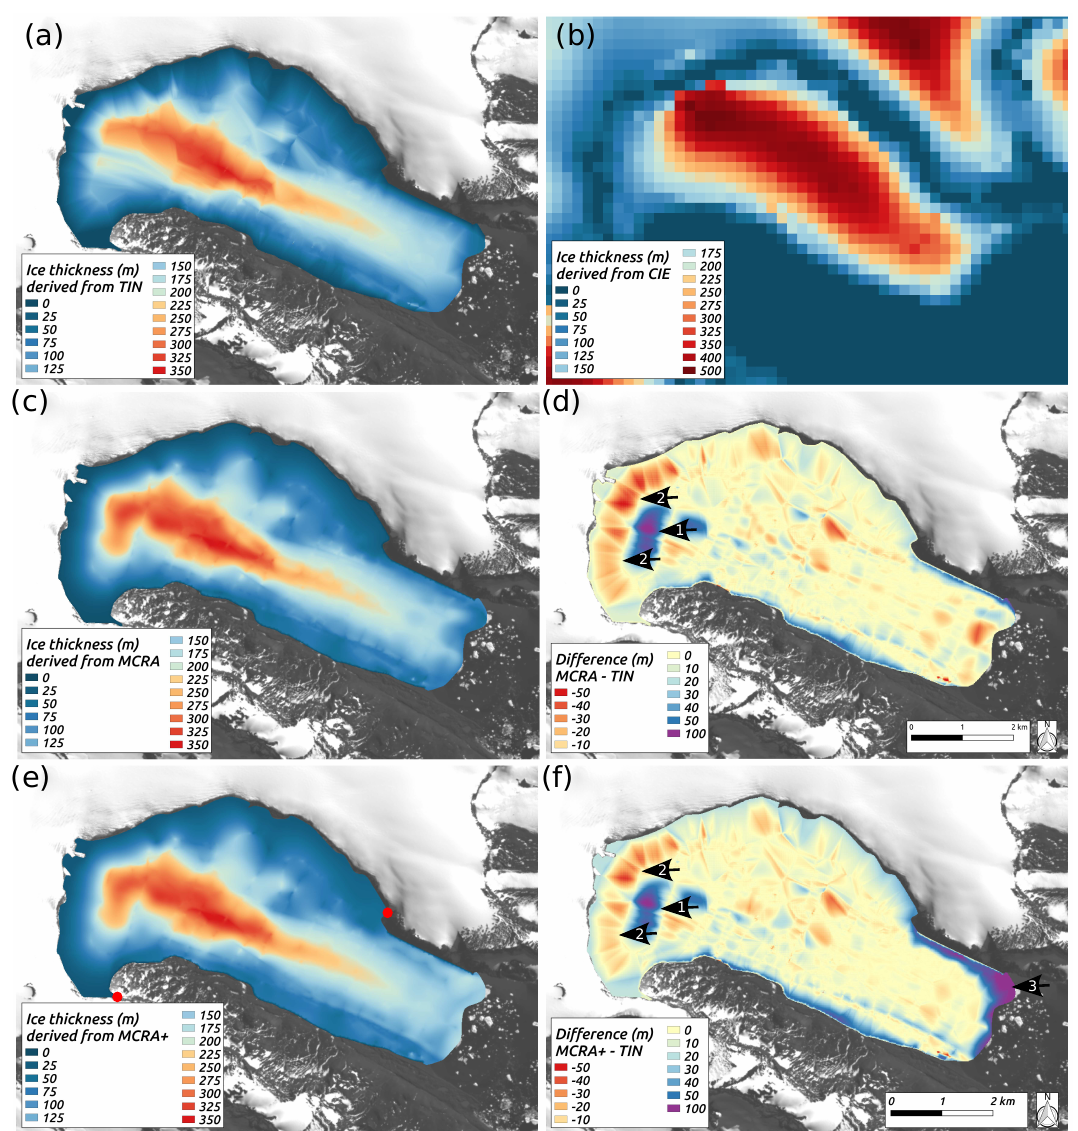
Figure 9. ( a ) Ice thickness measurements from 2018 with ( a ) TIN interpolation, ( c ) reconstruction using the MCRA, and ( e ) reconstruction using the MCRA+ with adding mass input from the plateau. ( b ) Simulated CIE data (Farinotti 2019). ( d , f ) Ice thickness differences (m) between the MCRA and the TIN ( d ) as well as between the MCRA+ and the TIN ( f ). The color bar of ( a – c , e ) is identical, except that the colors in ( b ) were extended with the classes larger than 350m. Background image: Landsat-8 (20 February 2017, courtesy of the U.S. Geological